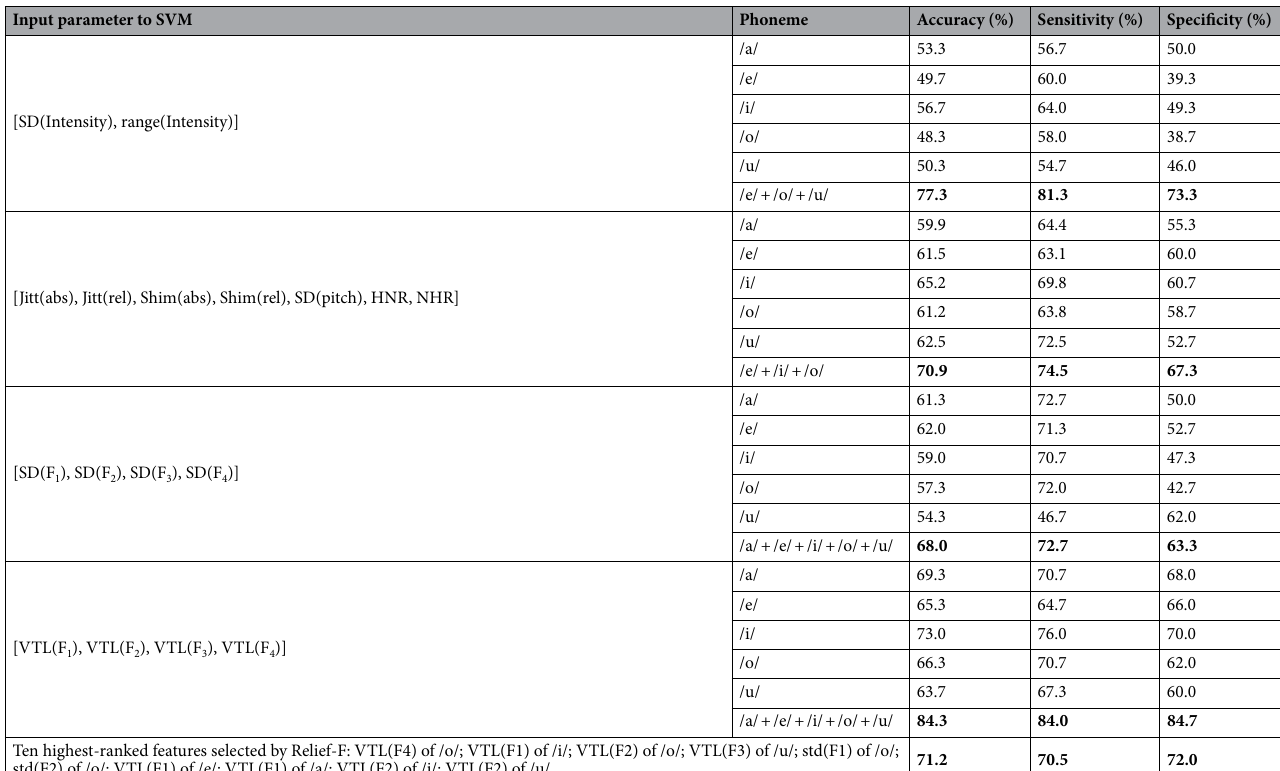
Table 4. The SVM classification results of PC-GITA database. Significant values are in bold.